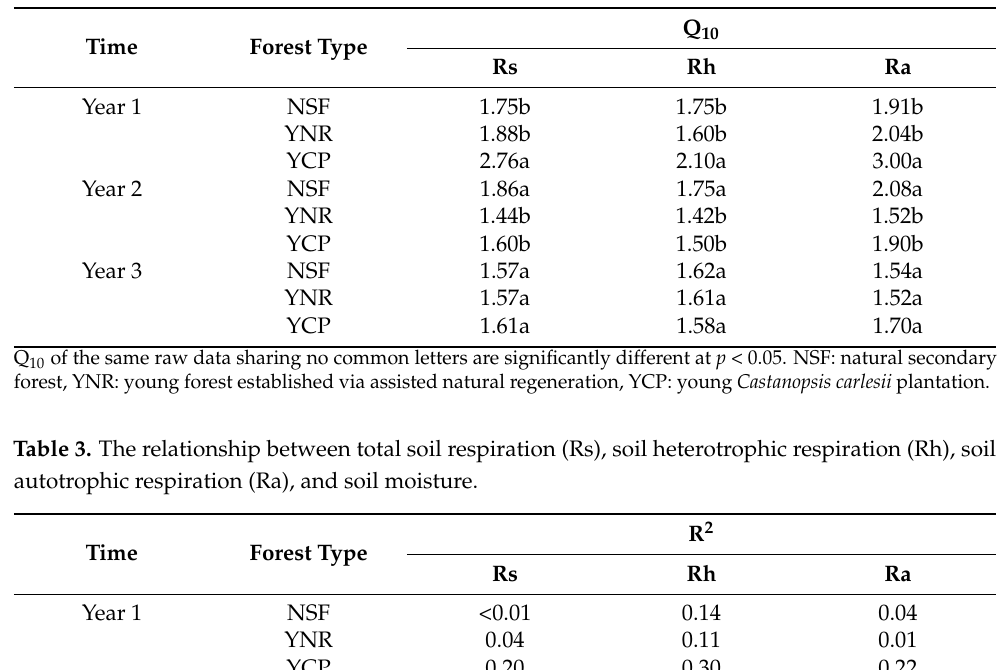
Table 2. The temperature sensitivity (Q 10 ) of total soil respiration (Rs), soil heterotrophic respiration (Rh), and soil autotrophic respiration (Ra).